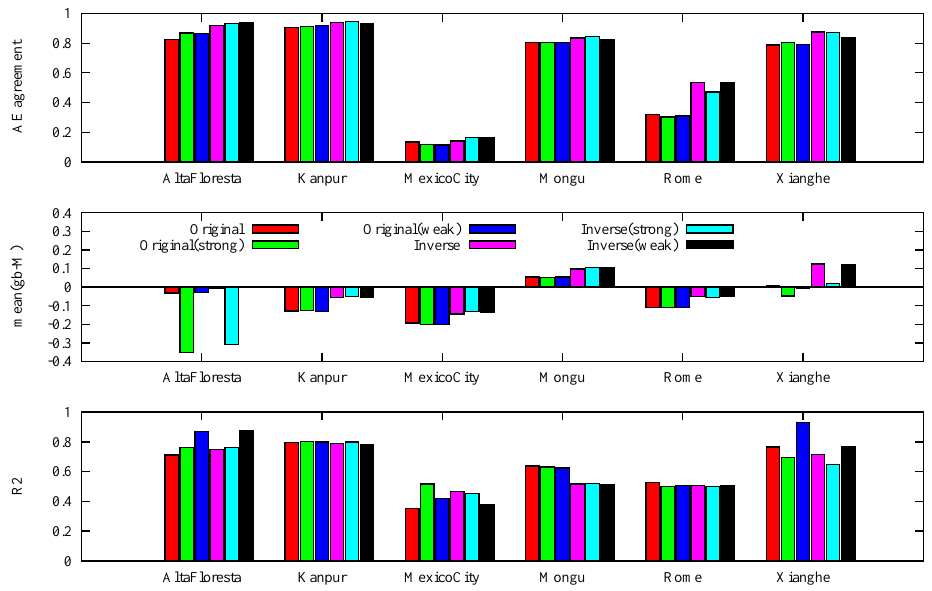
Fig. 7. Comparison of the AE and AOD agreement parameters from the original retrieval (Original), and the retrieval with the inverse NDVI-slope relationship (Inverse) at 6 sites. In addition, retrievals where aerosol models were assigned to be either a strongly absorbing (strong, SSA 550nm =0.86) or weakly absorbing (weak, SSA 550nm =0.95) are presented for both classes. Colors of the bars refer to these different retrievals. AE agreement (top panel) refers to the fraction of AE agreement while mean(gb–M) (middle panel) is the averaged AOD difference between the instruments and R2 (bottom panel) is the correlation coefficient for AOD. These values are also presented in Table 3.